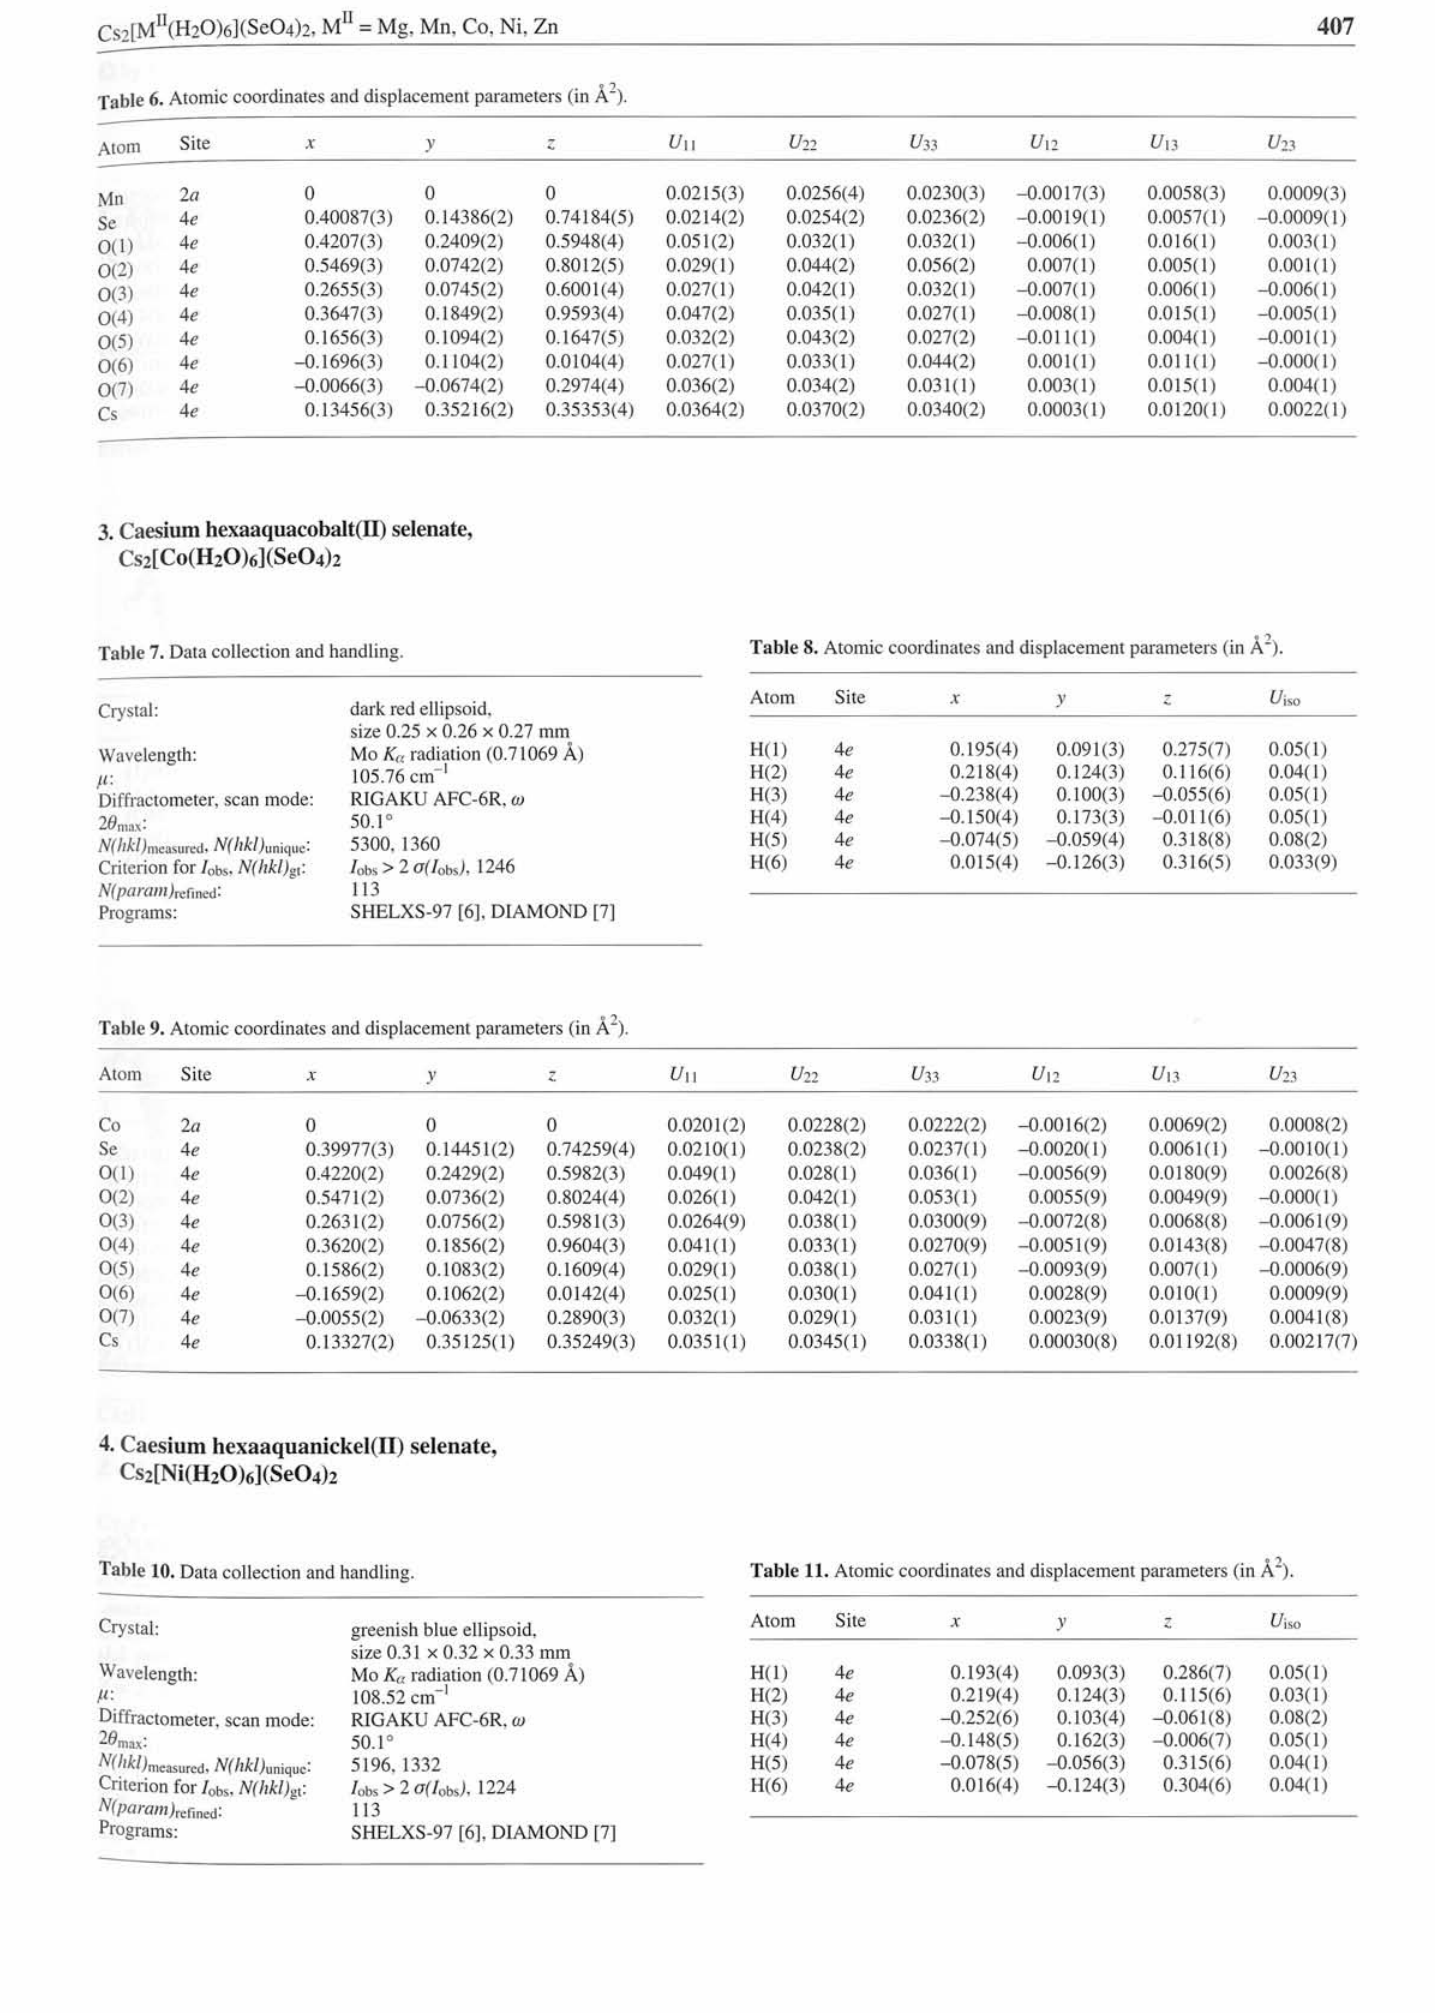
Table 6. Atomic coordinates and displacement parameters (in Â").